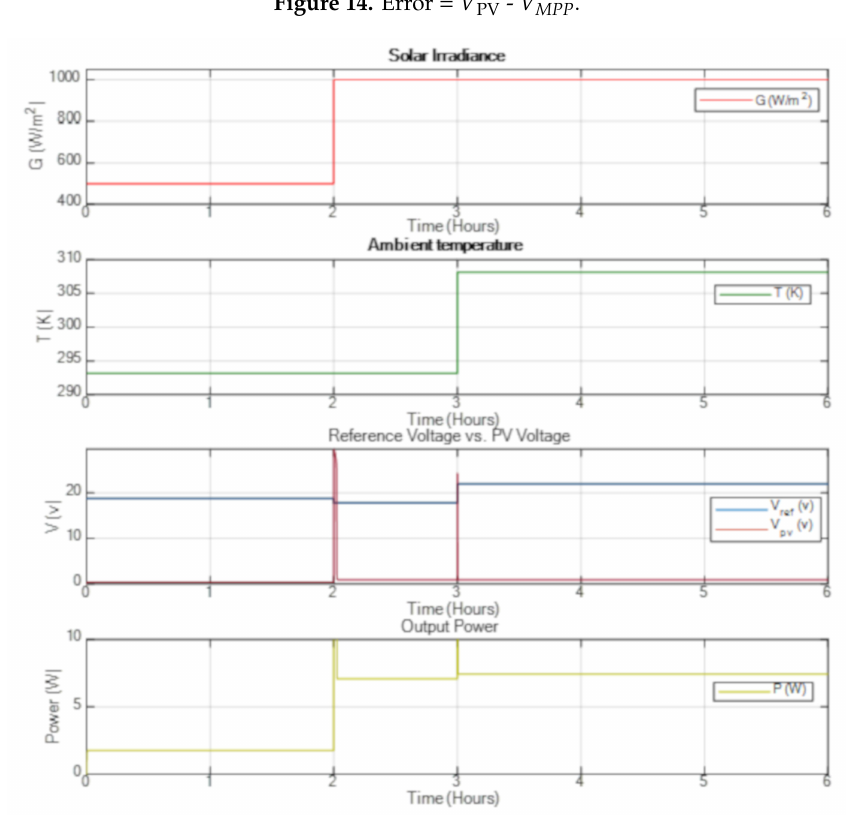
Figure 15. Output Power without Regulator for R = 10 Ω